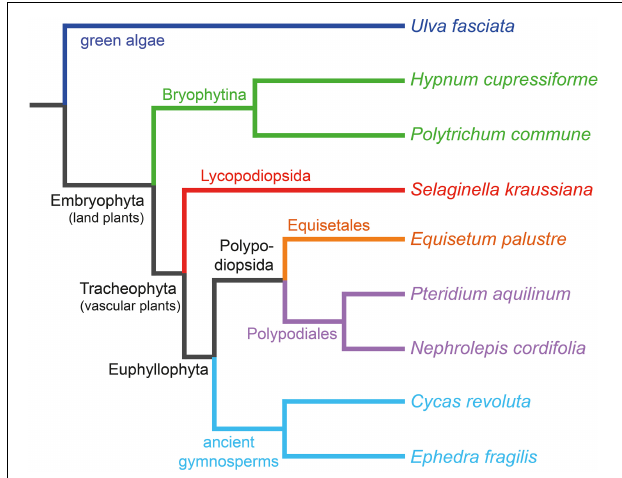
FIGURE 1 | Phylogenetic tree of the eight ancestral plants whose lignin-like fractions are analyzed, with the green alga Ulva fasciata Delile as an outsider to root the tree. Generated by phyloT v2 (https://phylot.biobyte.de/about.cgi).